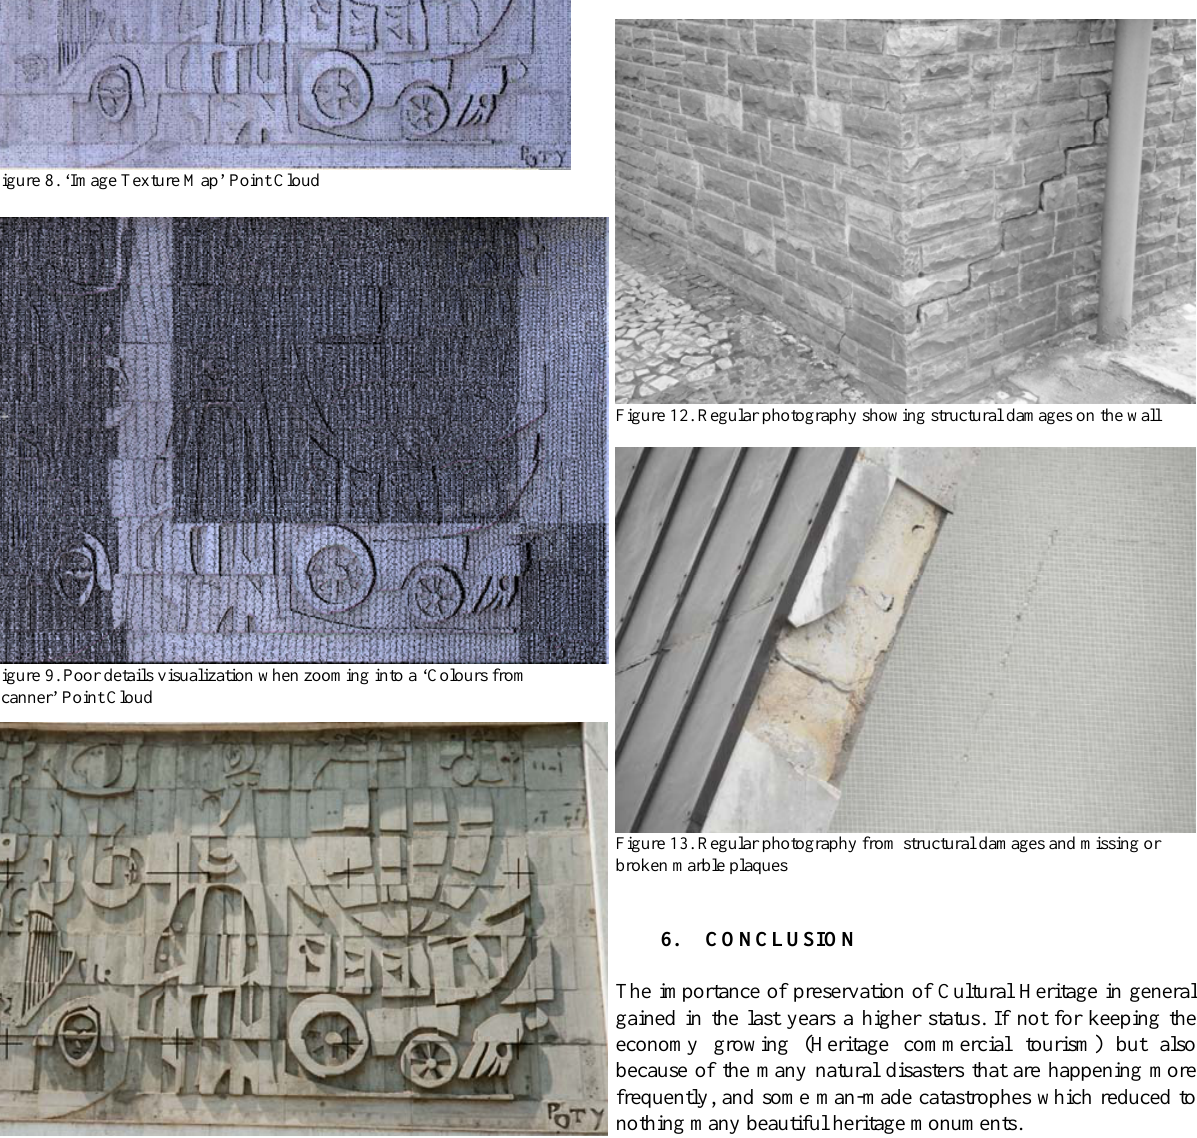
Figure 10. High resolution photograph taken with a close-range photogrammetric camera